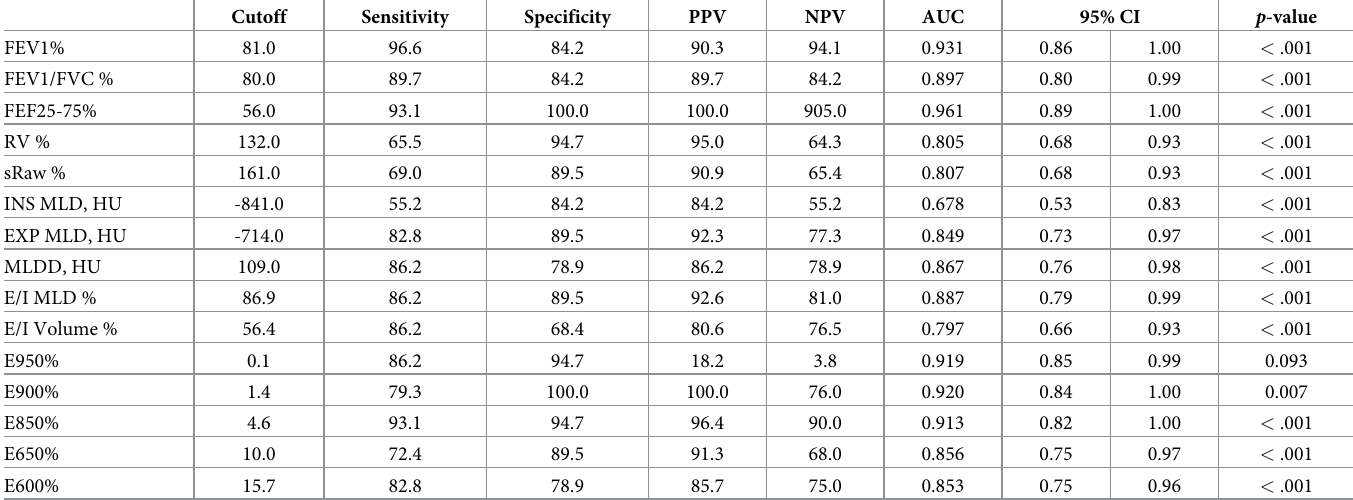
Table 4. Cut off, Sensitivity, specificity, and their area under the curve (AUC) with 95% CI of LDIs for diagnosis of BO.